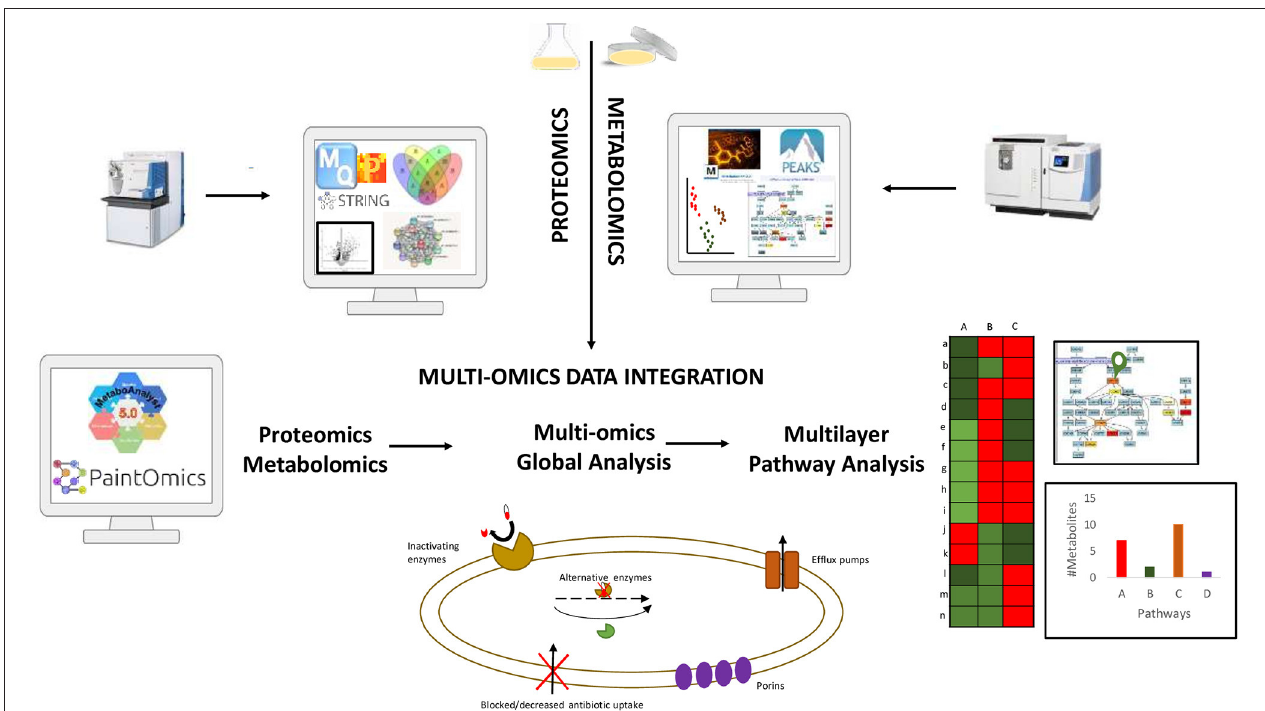
FIGURE 1 | Summary of data integration workflow combining proteomics and metabolomics data for a comprehensive understanding of the biochemical alterations of pathogenic drug resistant